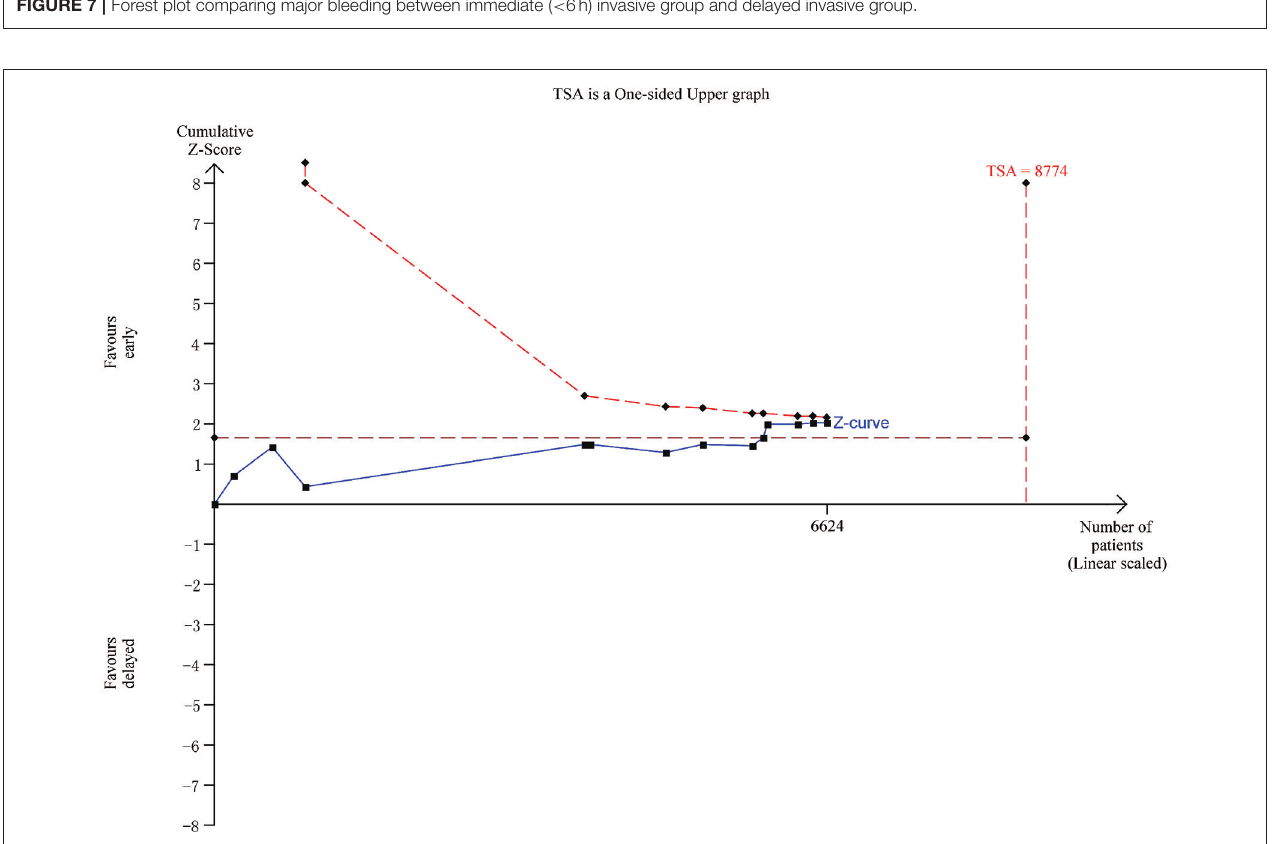
FIGURE 7 | Forest plot comparing major bleeding between immediate ( < 6h) invasive group and delayed invasive group.